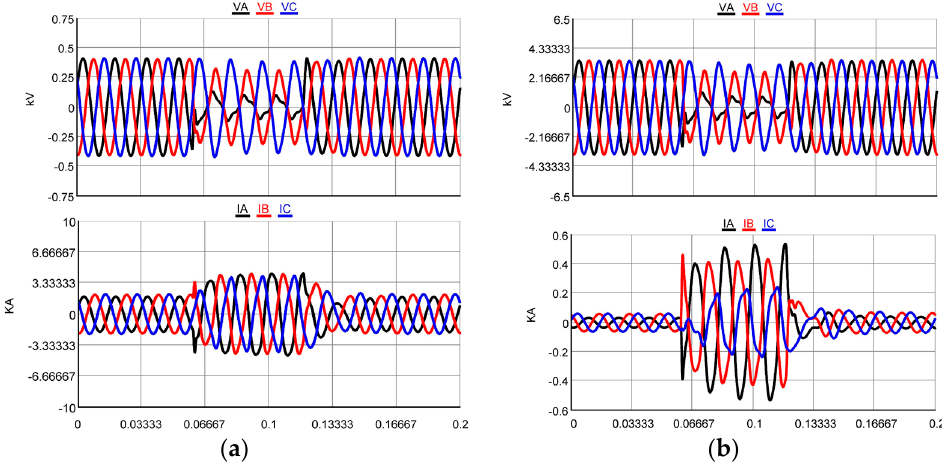
Figure 9. Single line-to-ground fault applied at bus 6 in the transmission system of the testbed: ( a ) instantaneous voltage and current at bus 634; ( b ) instantaneous voltage and current at bus 680.